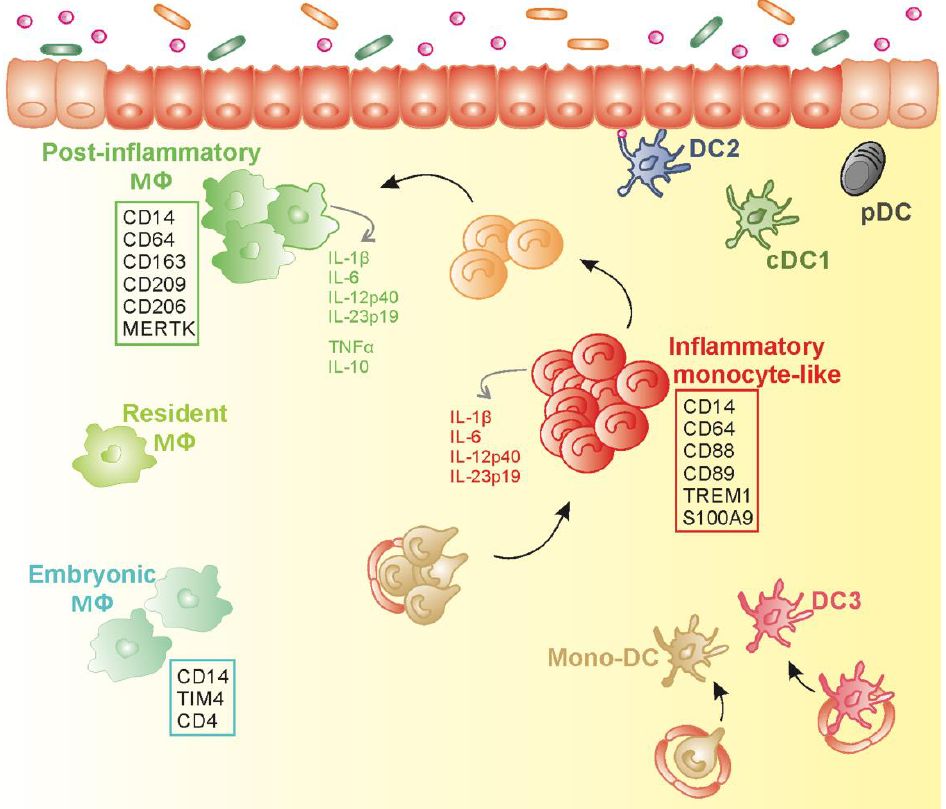
Figure 4. Proposed schematic model for mononuclear phagocytes diversity in inflamed colon of inflammatory bowel disease (IBD) patients. In inflamed IBD gut mucosa, the accumulation of HLADR dim CD14 + CD163 − CD89 + TREM + inflammatory monocyte-like subset (Inf Mo-like) (in red) secreting pro-inflammatory cytokines, could result from the increase recruitment of circulating CD14 hi monocytes (in gold) that differentiate into Inf Mo-like cells in concert with the potential arrest in the maturation program towards HLADR hi CD14 hi CD209 + MERTK + post-inflammatory M ɸ (in green) that likely contribute to tissue repair. Transitioning cells (in orange) are generated during this maturation process. Post-inflammatory M ɸ coexist with resident M ɸ (in yellow – green) that represent the predominant M ɸ population at steady state. M ɸ expressing TIM-4 + and CD4 + (in mint green), like embryonic M ɸ reported in mice, have been identified in the inflamed colon of IBD patients. Besides Inf Mo-like cells and M ɸ , conventional dendritic cells that include cDC1 (in khaki), DC2 (in blue), and plasmacytoid DC (in black) are seeded in the inflamed mucosa. Inflammatory monocyte-derived DC (in gold) and inflamed DC3 (in dark pink) may infiltrate inflamed lamina propria in IBD patients.